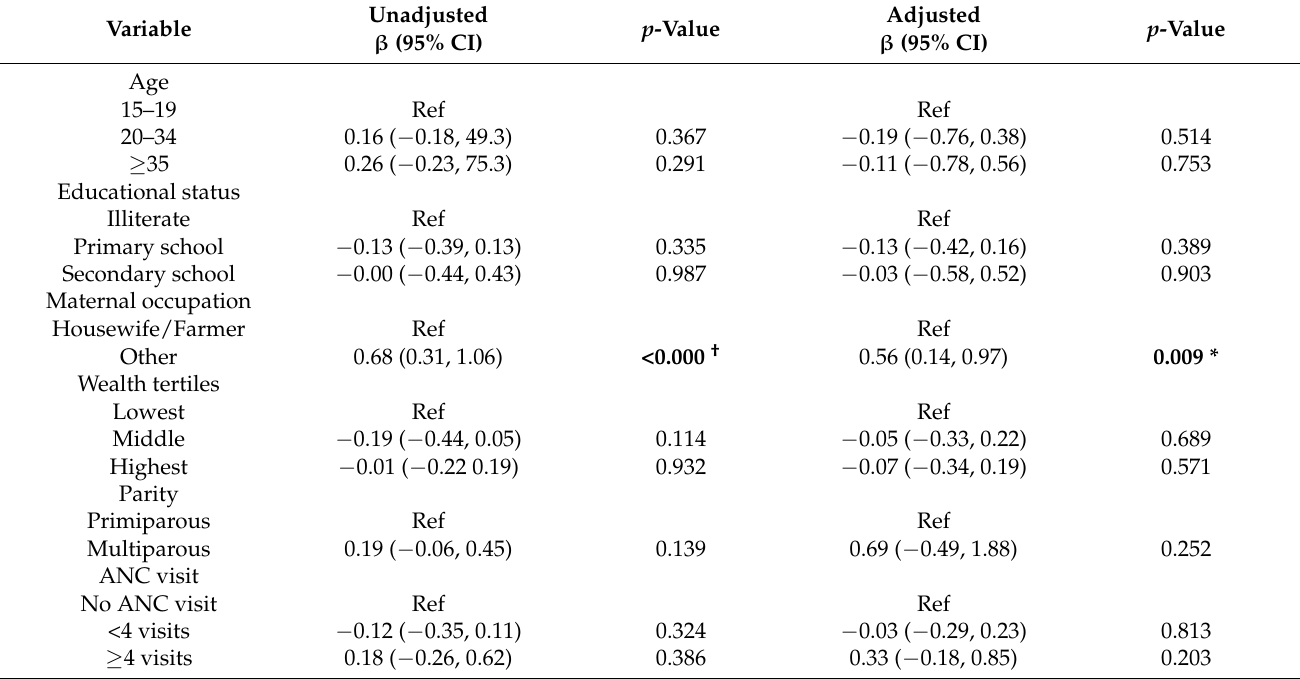
Table 2. Predictors of breastfeeding knowledge using the BFKQ-AO among 468 pregnant rural Ethiopian women participat- ing in breastfeeding education and support intervention (BFESI).